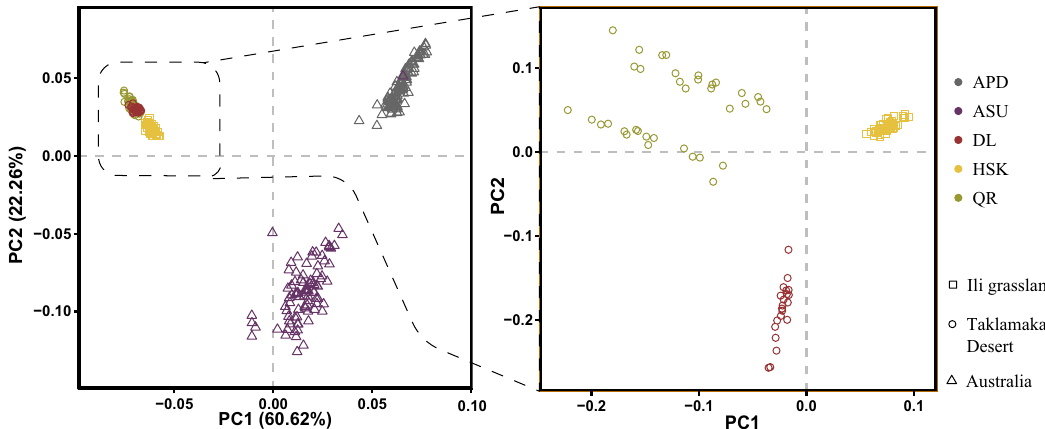
Figure 1. The PCA analysis chart of sheep breeds in three geographic regions, the X-axis represents PC1, and the Y-axis is PC2. The picture on the left shows the genetic distances of five sheep breeds, and that on the right shows the genetic distances of three sheep breeds in the Taklimakan Desert and the Yili